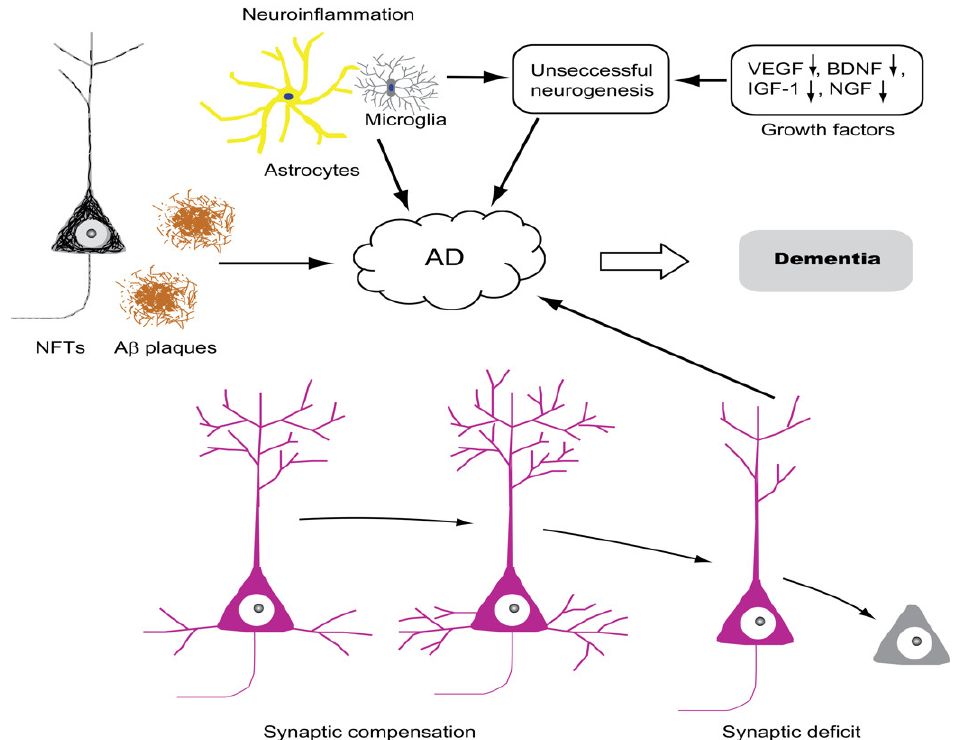
Figure 2. AD is a multifactorial disease. AD is a proteopathy that is characterized by the extracellular deposition of A β plaques and the intracellular deposition of NFT of hyperphosphorylated tau. Neurodegeneration is an established process in AD and its presence in the cortical association areas directly correlates with memory loss. A transient increase in the level of synaptic markers known as the phenomenon of synaptic compensation is present at the early stages of the disease, which is followed by the loss of synapses and synaptic deficit. Synaptic deficit also directly correlates with cognitive impairment in AD patients. Systemic inflammation and cytokine storms are established phenomena in AD; three main effector cells are implicated in this process: mast cells, central nervous system (CNS) microglia and astrocytes. CNS microglia are known to control neurogenesis. Hence, an overactivation of these cells would cause more newborn neurons to die by apoptosis, leading to a deficit in neurogenesis. All of these factors together or separately could be the cause of AD, which results at the end in memory loss and cognitive impairment.